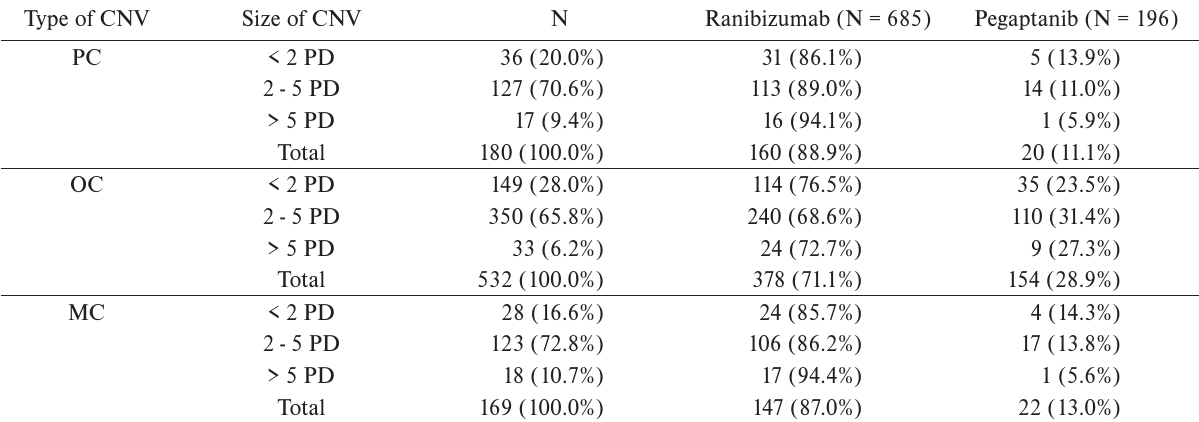
Table 2. Use of ranibizumab and pegaptanib depending on the type and size of CNV. Type of